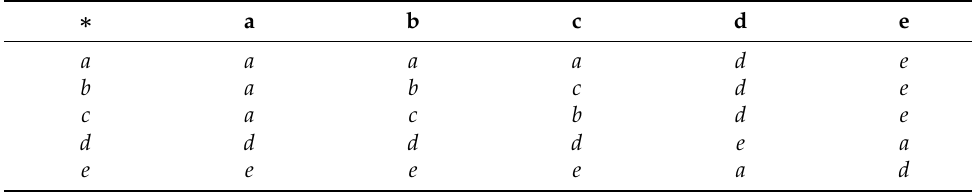
Table 7. This is an L1/R1-transposition regular